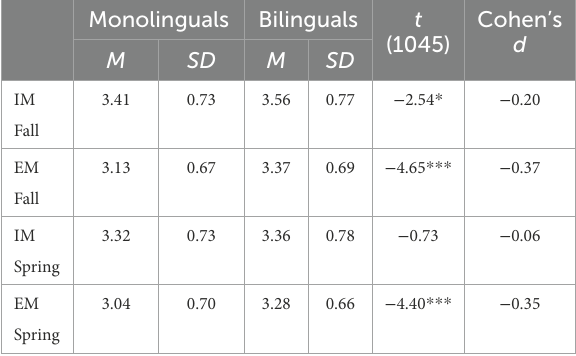
TABLE 1 Intrinsic and extrinsic motivation of monolingual and bilingual